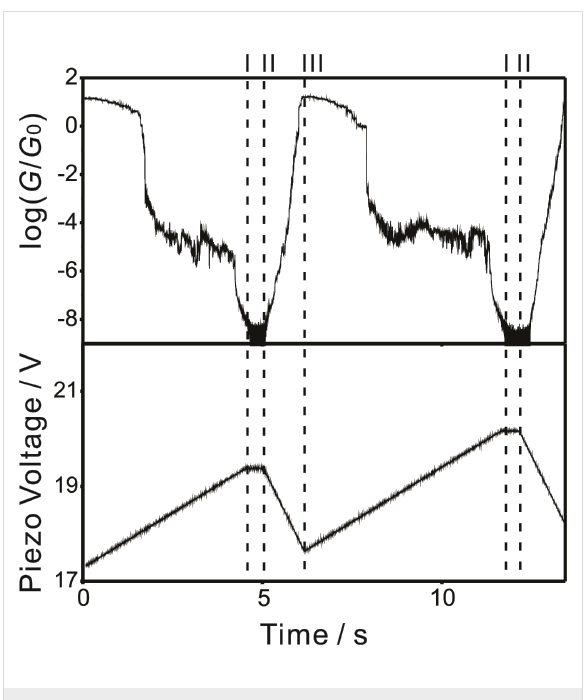
Figure 3: Conductance and voltage output for the piezo stack versus time for 0.1 mM AC in THF/decane (v:v = 1:4) under an Ar atmos- phere at 0.10 V bias